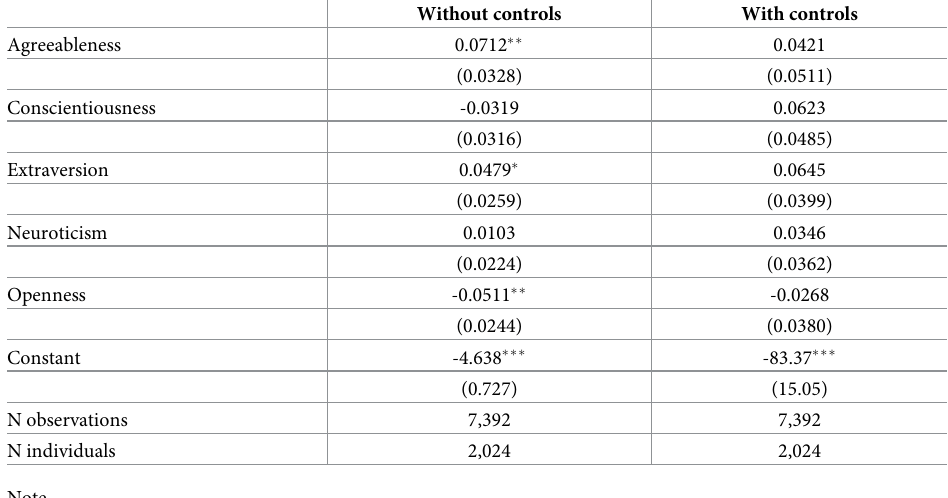
Table 5. Random effects logit estimates of the Big Five personality traits on the probability of leaving